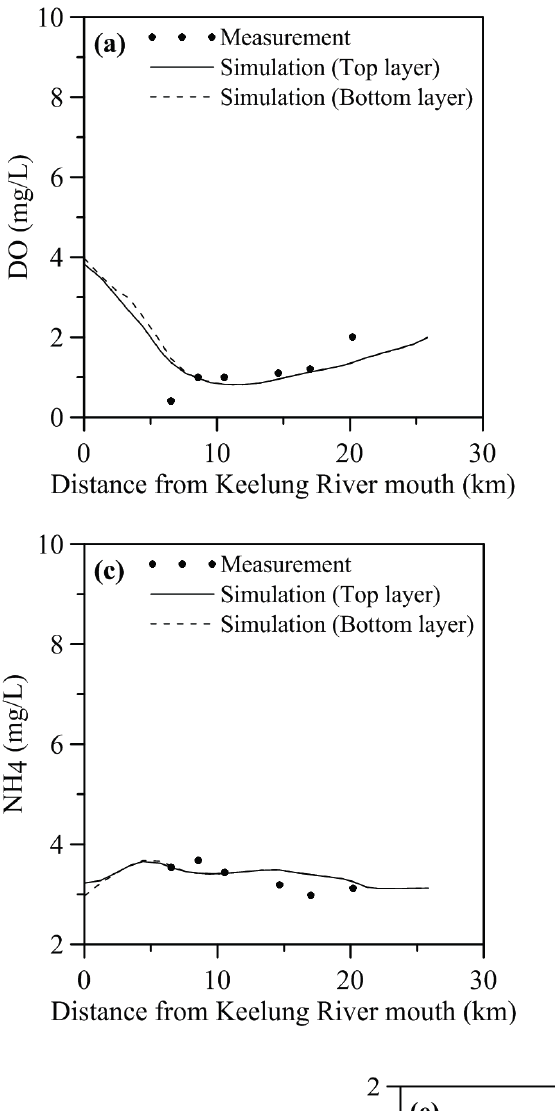
; ( d ) TP; and ( e ) NO 4 3 3